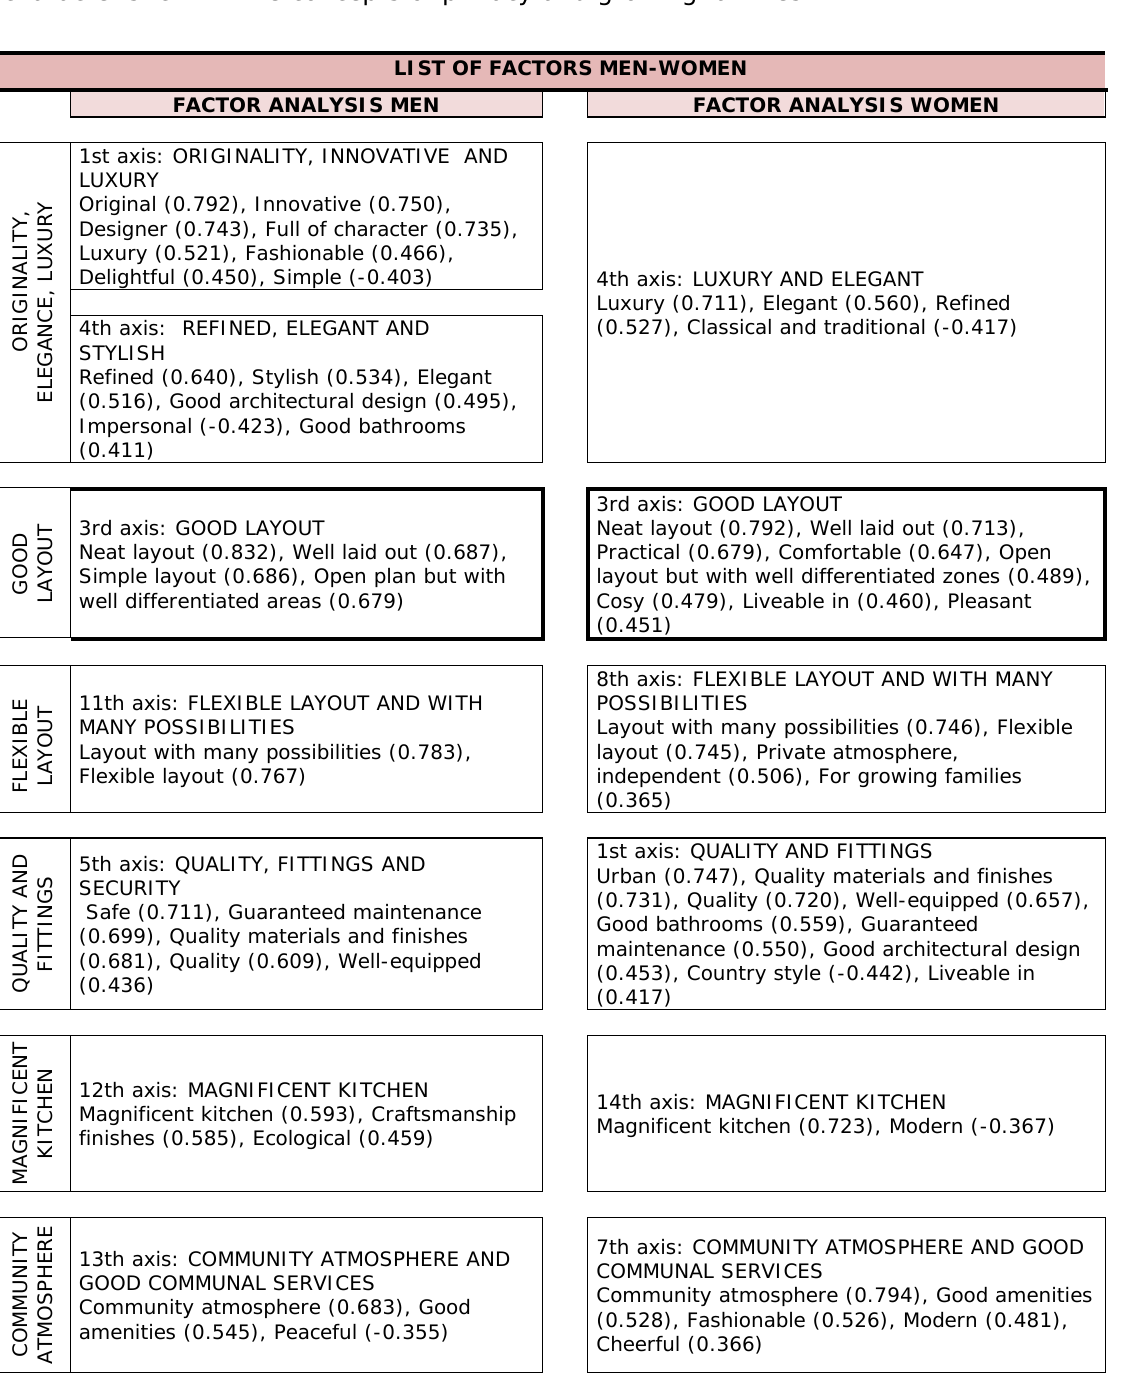
14th axis: MAGNIFICENT KITCHEN Magnificent kitchen (0.723), Modern